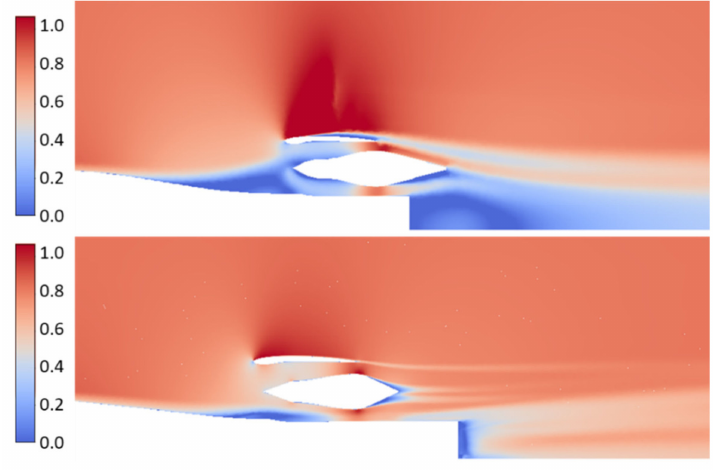
Figure 13. Contours of Mach number. Comparison between 2D ( upper ) and 3D ( lower ) simulations for case h / D = 0.6, e / D = 0, l a / D = l b / D =